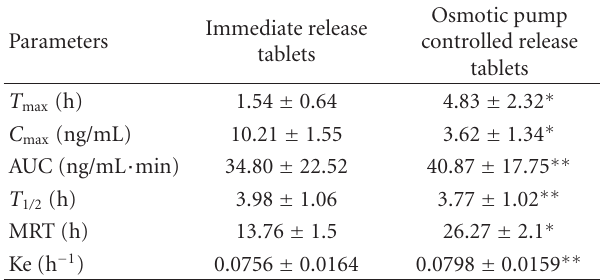
Table 4: The pharmacokinetic parameters (vinpocetine) in dogs after oral administration of 15 mg vinpocetine osmotic pump